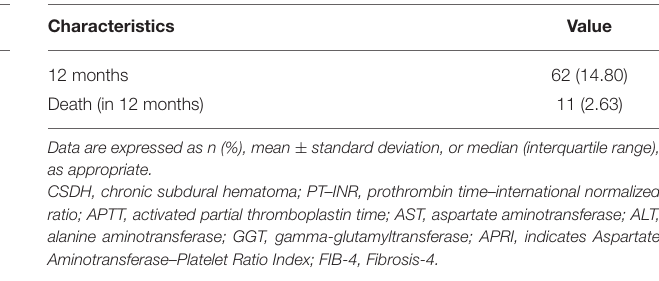
TABLE 1 | Baseline characteristics and outcomes of 419 patients with